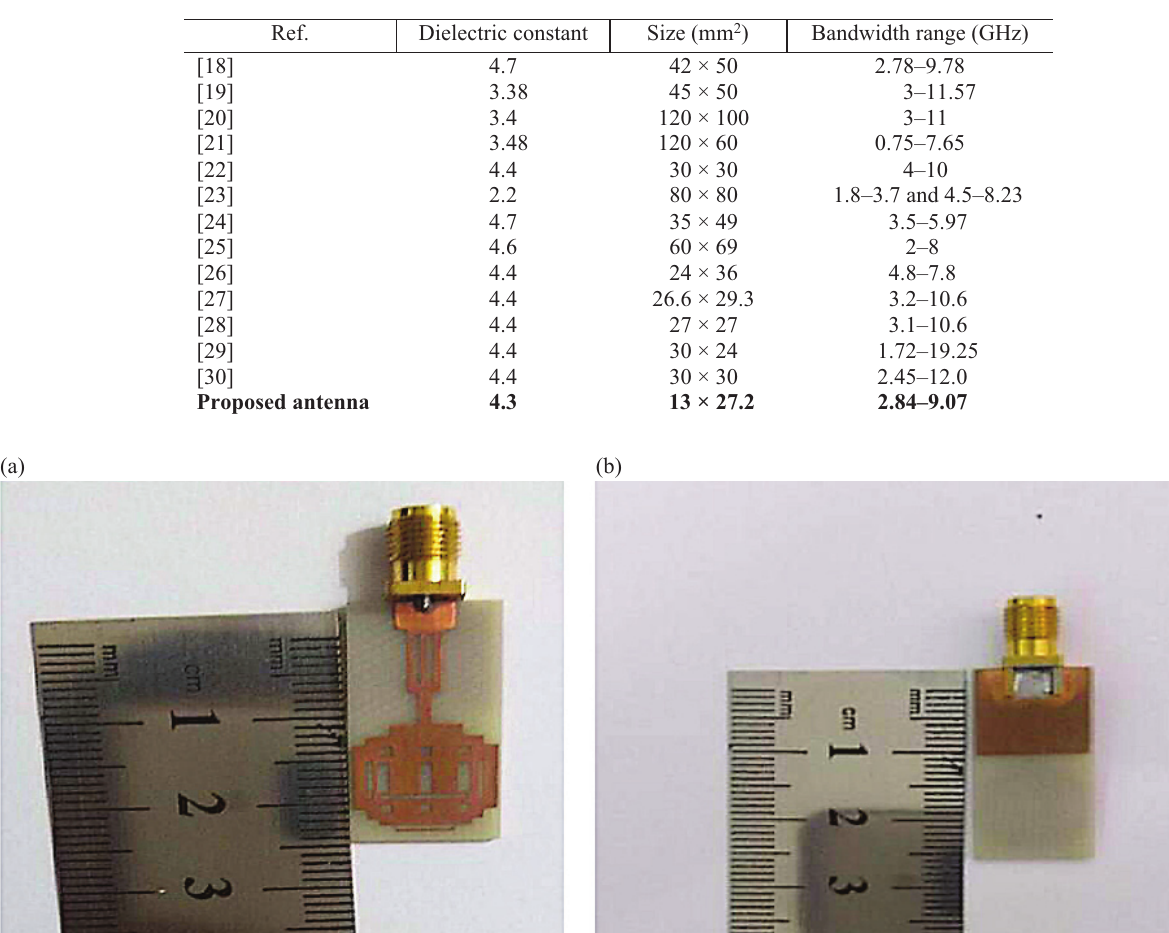
Fig. 9. Far-field radiation patterns for the projected antenna at 5.5 GHz. Table 1. Comparison of the reported UWB antennas